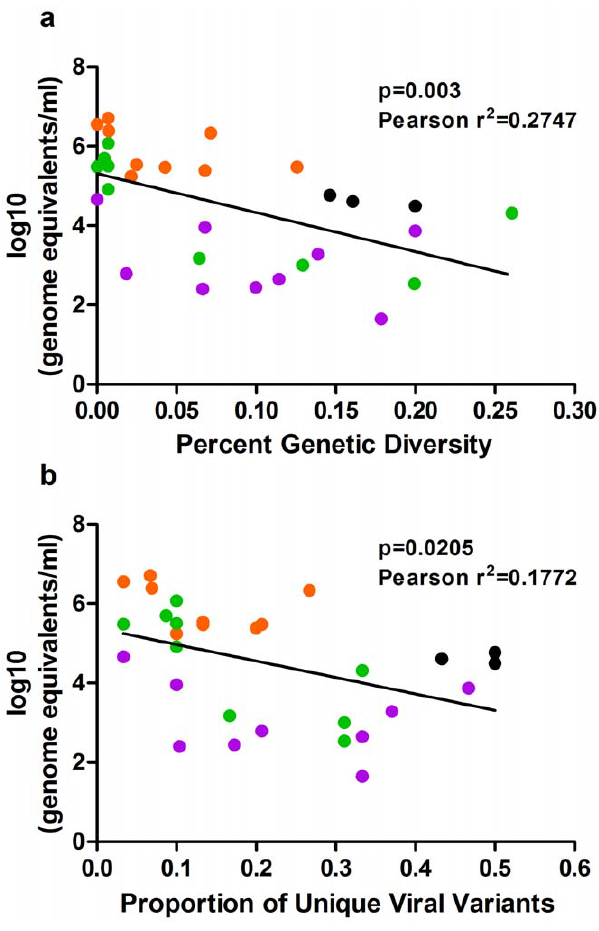
Figure 3. Viral genome equivalents and genetic diversity are inversely correlated. Black=‘input’, Orange=midguts, Green=legs, and Purple=saliva. (A) Log transformed genome equivalents for each sample plotted against percent nucleotide diversity, n=30, p=0.003, Pearson r 2 =0.2747. (B) Log transformed genome equivalents for each sample plotted against the proportion of unique viral variants, n=30, p=0.0205, Pearson r 2 =0.1772.